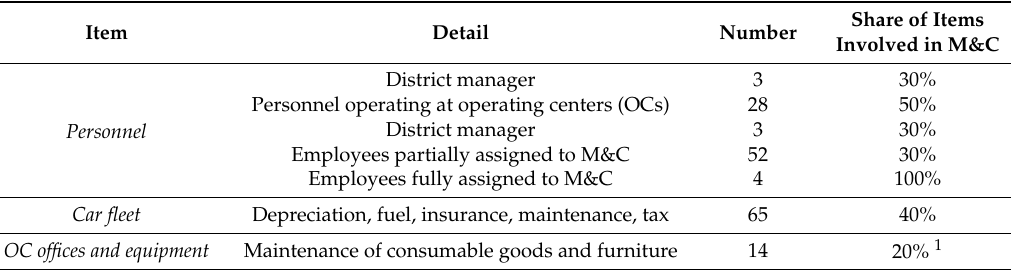
Table 4. Allocation shares for the CBC joint